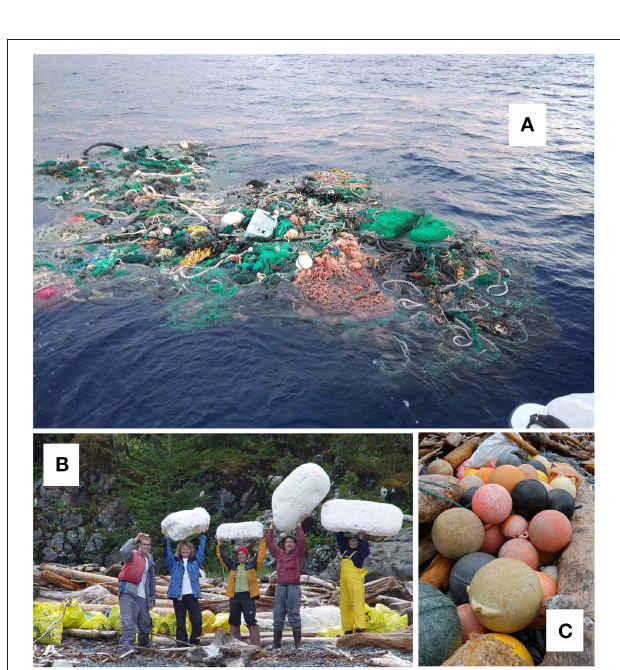
FIGURE 2 | Derelict fishing nets (A) floating in the eastern North Pacific. Photo courtesy of Raymond McCormack, who tagged the net with a satellite tracker during the Ocean Voyages Institute’s projects. Styrofoam (B) and plastic (C) fishing buoys, removed from the shoreline of Alaska. Photos courtesy of Christopher Pallister, Gulf of Alaska Keeper 15 (Maximenko has permissions from McCormack and Pallister to use the photos).